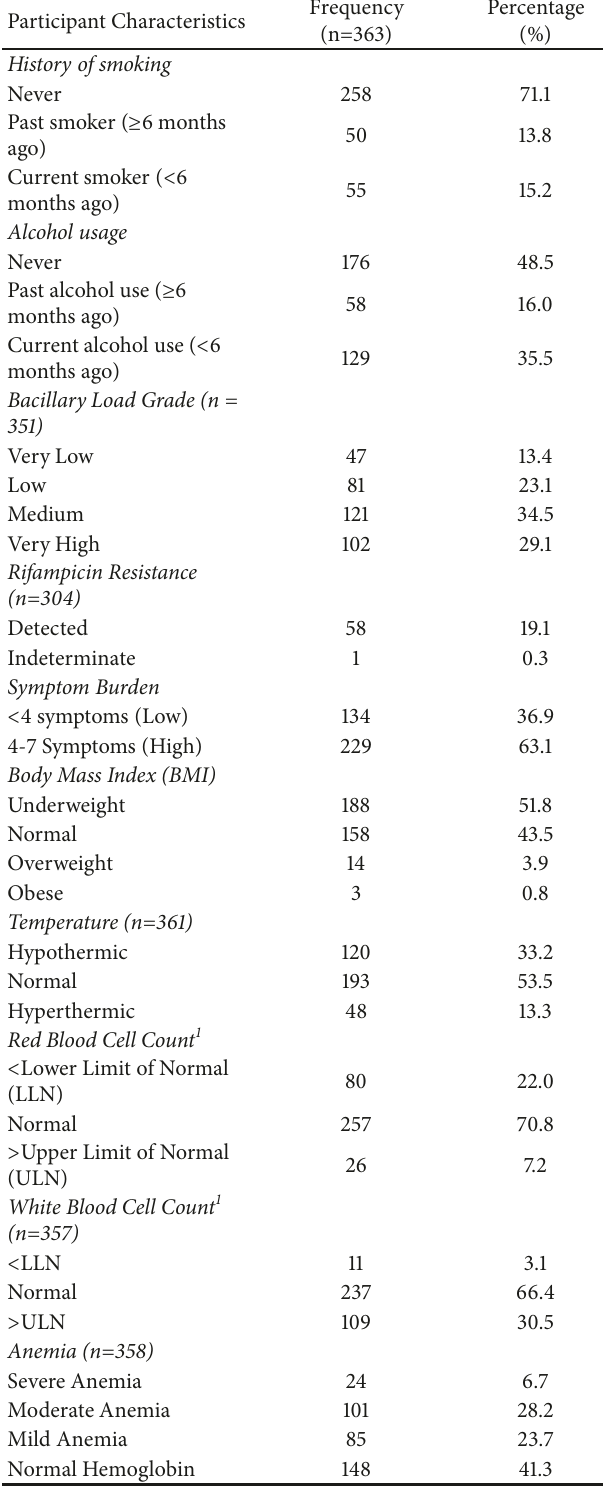
Table 2: Characteristics of study